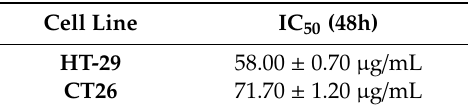
Figure 2. Time-dependent in vitro anticancer activity of OOEO against colon cancer cell lines. Antiproliferative e ff ect of increasing doses of OOEO at 72 h (solid lines, circles) or 48 h (dashed lines, triangles) on human (HT-29) and mouse (CT26) colon cancer cells. Cell growth percentage was analyzed with the SRB assay. All data shown are representative of at least three independent experiments. Values represent mean ± SD. Table 3. IC 50 values (e ffi cient concentration that causes a 50% decrease in cell growth) of OOEO against human (HT-29) and mouse (CT26) colon cancer cells determined with the SRB assay after a 48 h treatment. Data are representative of at least three independent experiments and are presented as mean ±